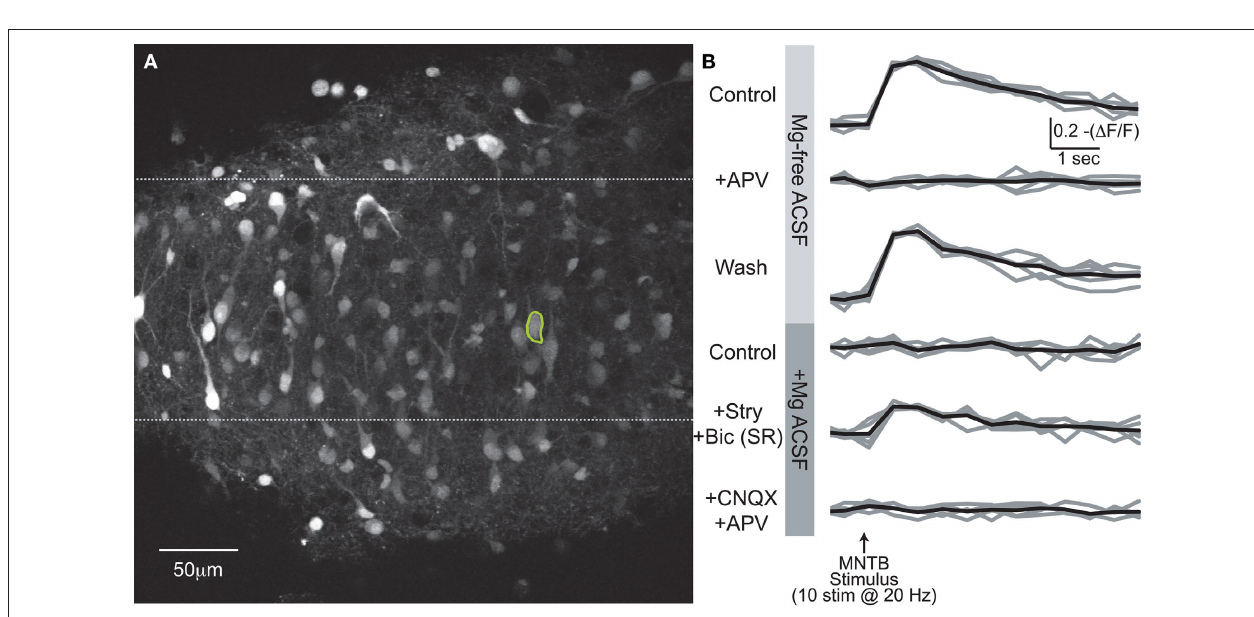
FiGUre 6 | Somatic Ca 2 + responses. (A) Compressed z -stack of Fura2-AM stained LSO neurons. (B) Somatic Ca 2 + responses from circled cell in (A) for six experimental conditions. Average of five trials/condition in black. In last two conditions, drugs applied